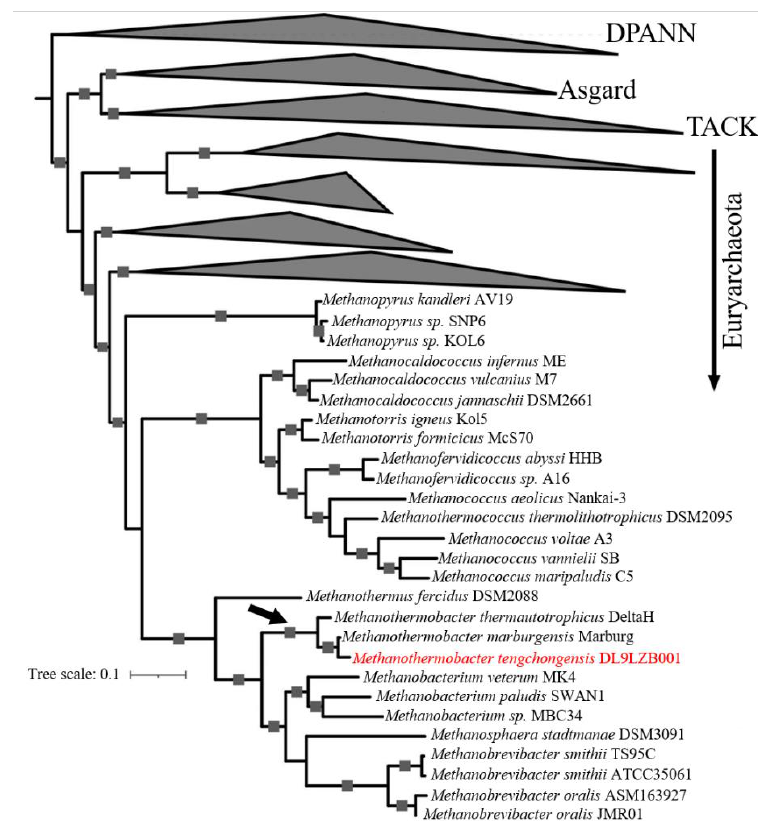
Figure 5. Phylogenomic affiliation of M. tengchongensis DL9LZB001. We constructed the phylogenomic tree based on 37 marker-protein sequences, with 233 representative archaea genomes from four superphyla: (from top to bottom) DPANN, Asgard, TACK, and Euryarchaeota [10]. The tree is rooted in the superphylum DPANN. The position of the genus Methanothermobacter is labeled with a black arrow, and DL9LZB001 is highlighted in red. Bootstrap values larger than 80 are marked as squares on the tree branch.